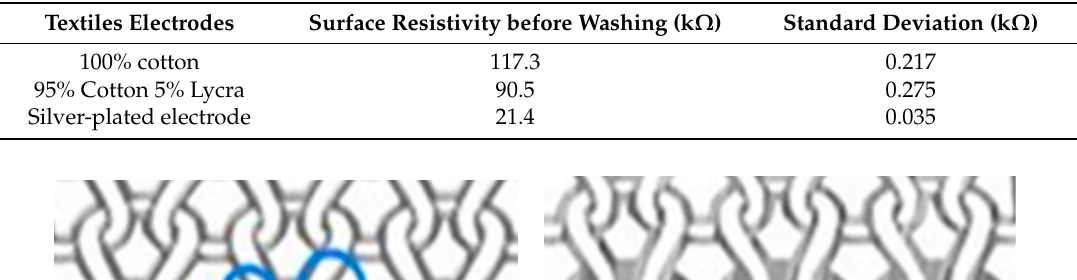
Table 2. Surface resistivity of textile electrodes.